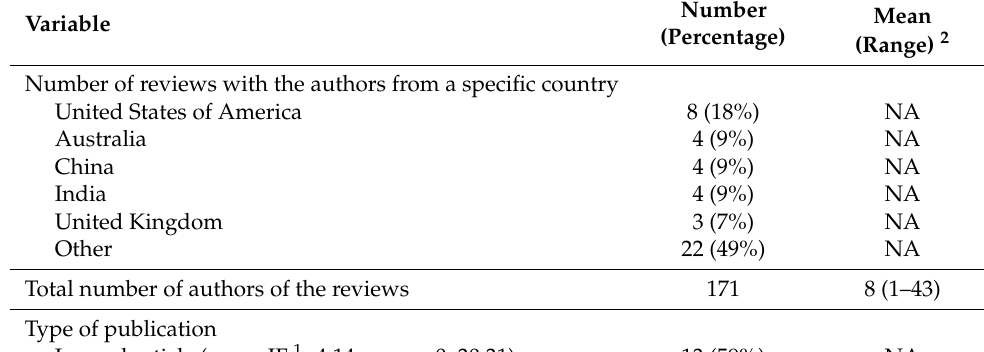
Table 1. Detailed characteristics of included